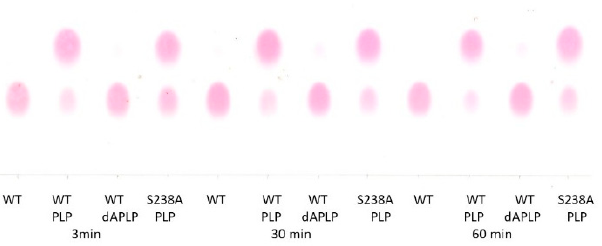
Figure 2. TLC chromatogram of reaction of D-lysine with WT, PLP/WT, dAPLP/WT and PLP/S238A in the presence of dAdoCbl. The time intervals were chosen at 3 min ( left ), 30 min ( middle ), and 60 min ( right ), respectively. Bottom spots are of D-lysine, whereas top spots represent the product 2,5-diaminohexanoic acid. Thus, WT and dAPLP/WT did not show any turnover, while PLP/S238A showed significant but less turnover than PLP/WT.